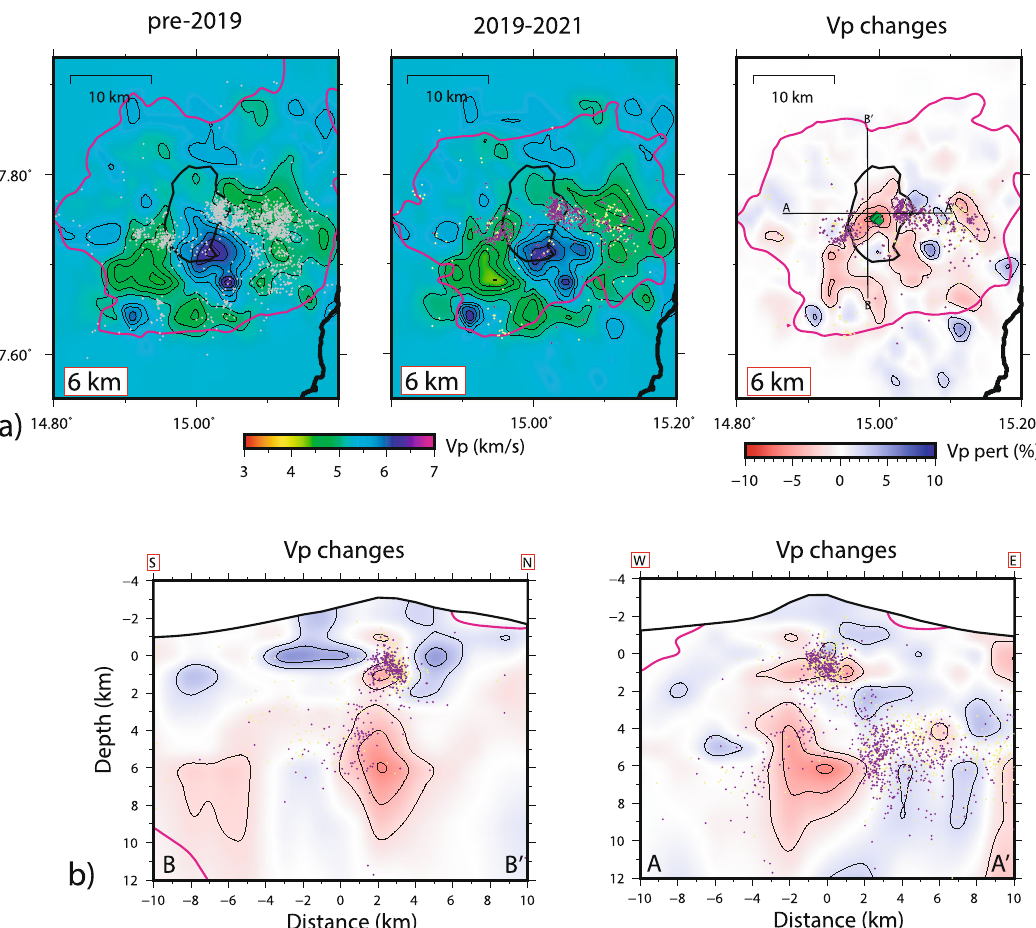
Fig. 3 Time-lapse tomography at Mt. Etna. ( a ) Vp at 6 km depth b.s.l. in the period before 2019 (background model) and in the period 2019 – 2021 (new model). Vp changes between the two models related to the variation of temperature and stress beneath the volcano. Seismicity occurred in the three distinct periods is shown (gray = pre 2019, yellow 2019 – 2020, purple 2020 – 2021 most recent). ( b ) S-N and W-E vertical sections of Vp changes crossing the volcano. Seismicity is represented with the same colors of ( a ). Purple lines = limit of the resolved volume. Green diamonds on the Vp changes map are the summit